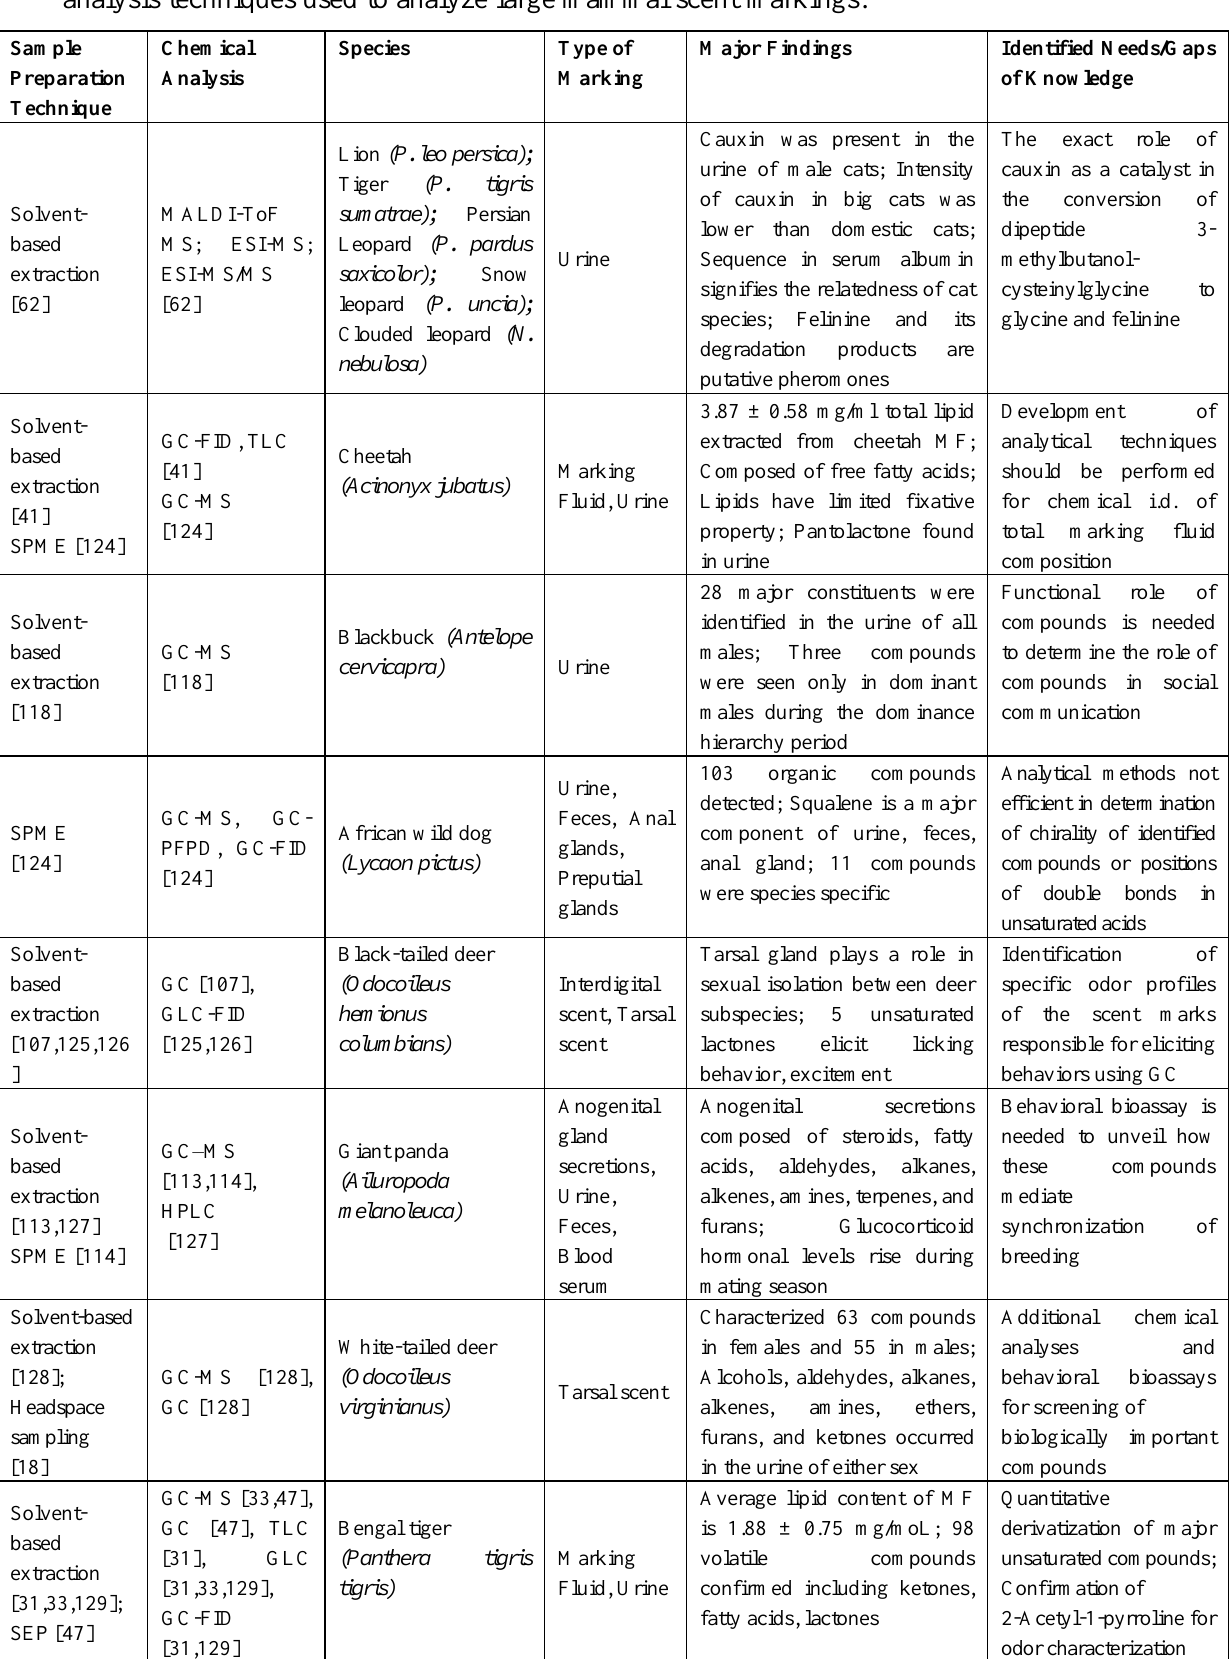
Table 1. Summary of findings and knowledge gaps in the area of sample preparation and analysis techniques used to analyze large mammal